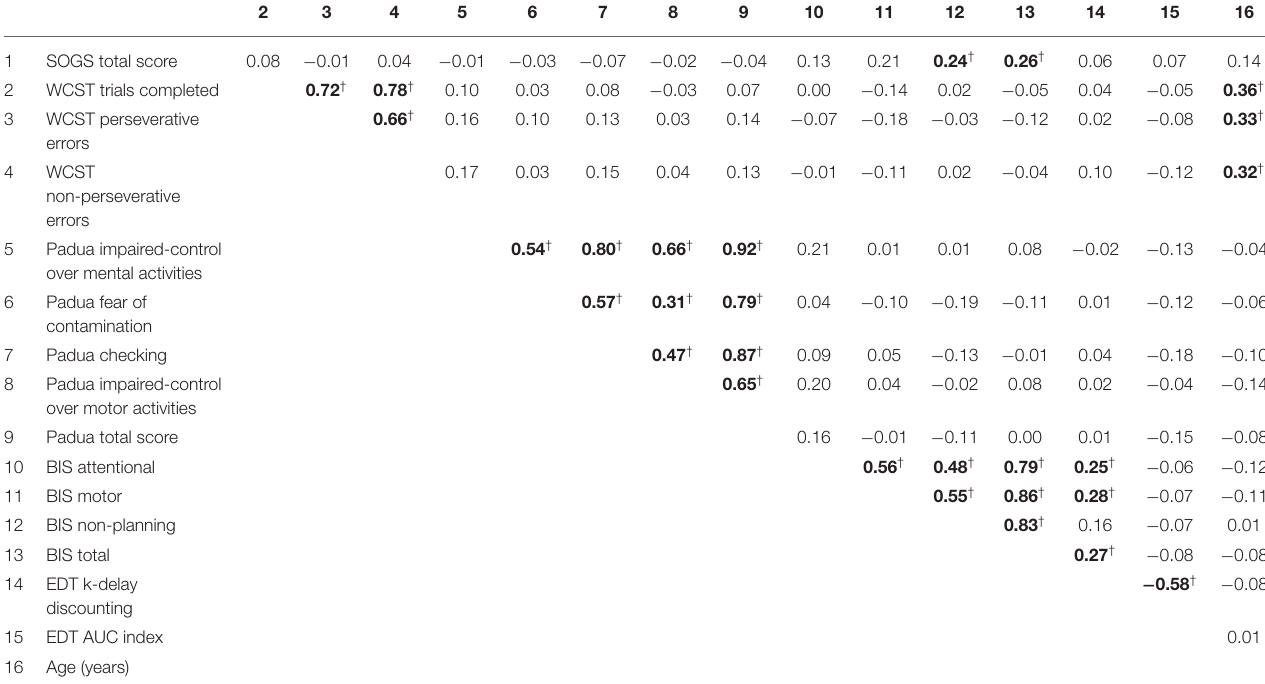
TABLE 2 | Correlations between the variables of the study.